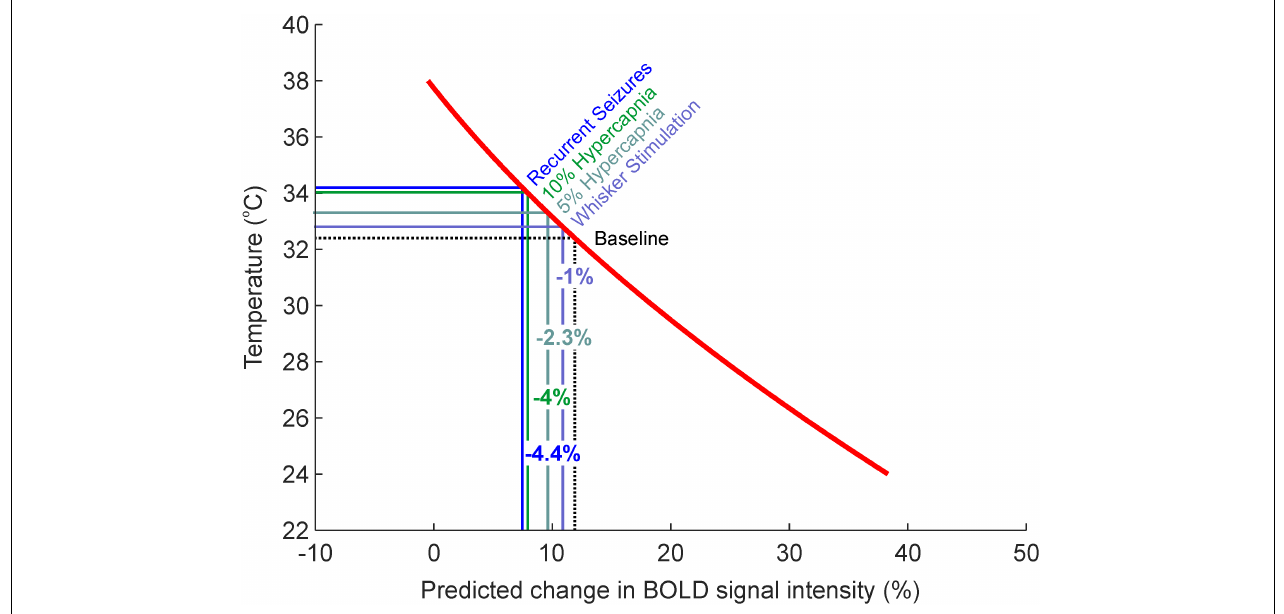
FIGURE 4 | Estimates of percentage changes in BOLD signal intensity due to intrinsic temperature variations such as those observed during sensory stimulation, graded hypercapnia and recurrent seizure activity ( Figure 1B ). Red regression curve from generalized regression model obtained in Figures 3C–F